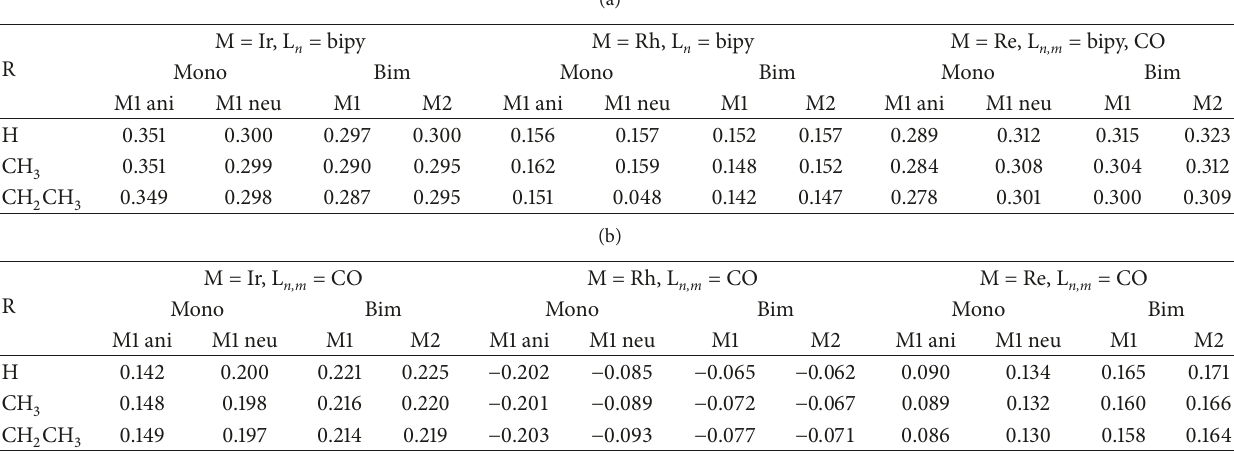
Table 2: Atomic charges in a.u. for the metal centers of the monometallic (anion and neutral) and bimetallic systems.